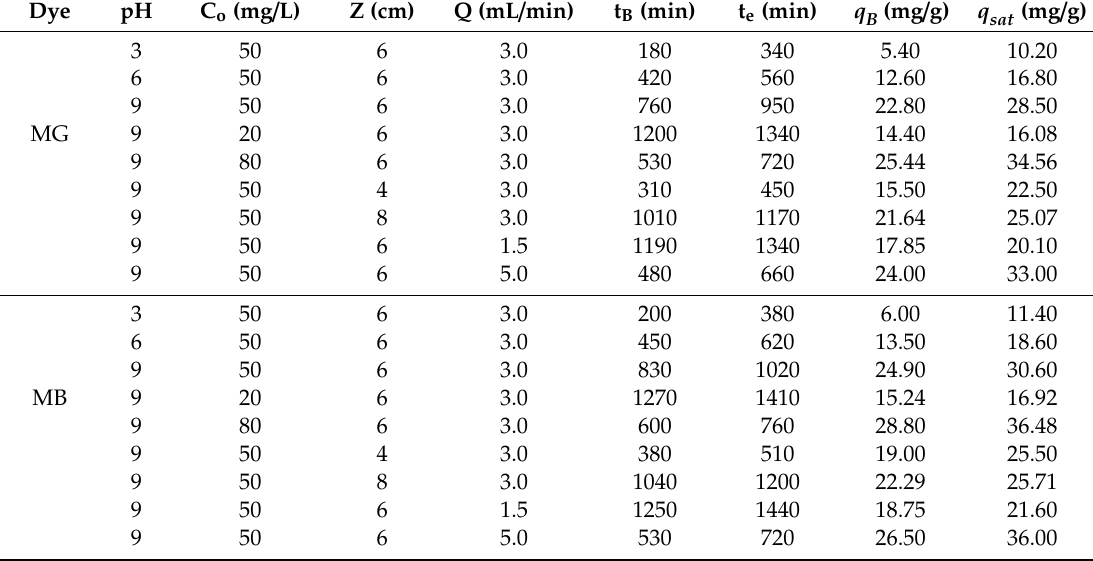
Table 4. Column adsorption data for MG and MB onto T-PAA in the binary